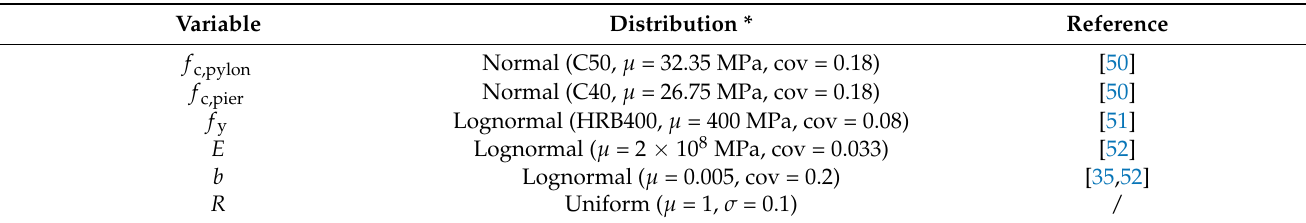
Table 2. Uncertainty parameters of the bridge and their probability